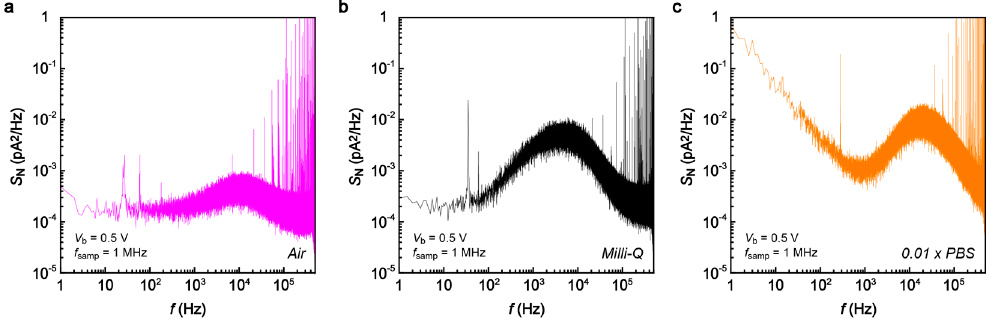
Figure 7. ( a – c ) Noise spectra in an air gap ( a ); Milli ‐ Q ( b ); and 0.01 × PBS ( c ) at 1 MHz sampling rate with a 1 MHz low ‐ pass filter.